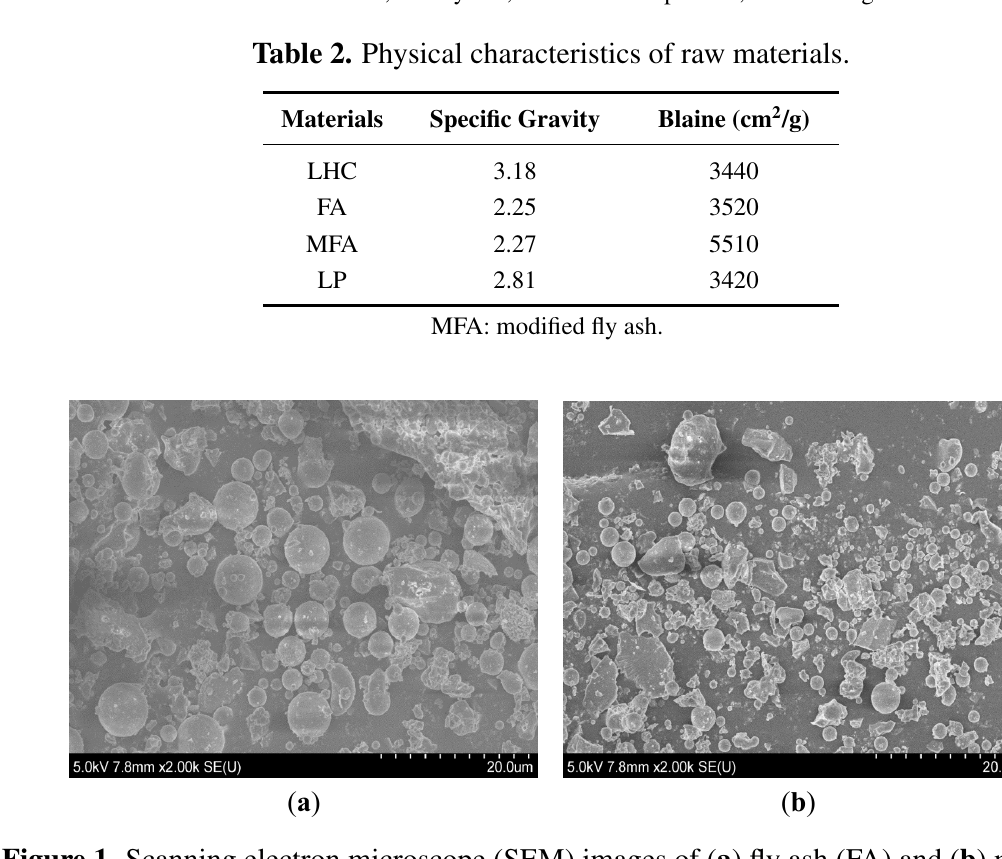
Figure 1. Scanning electron microscope (SEM) images of ( a ) fly ash (FA) and ( b ) modified FA (MFA) with particle size of 20 μ m.